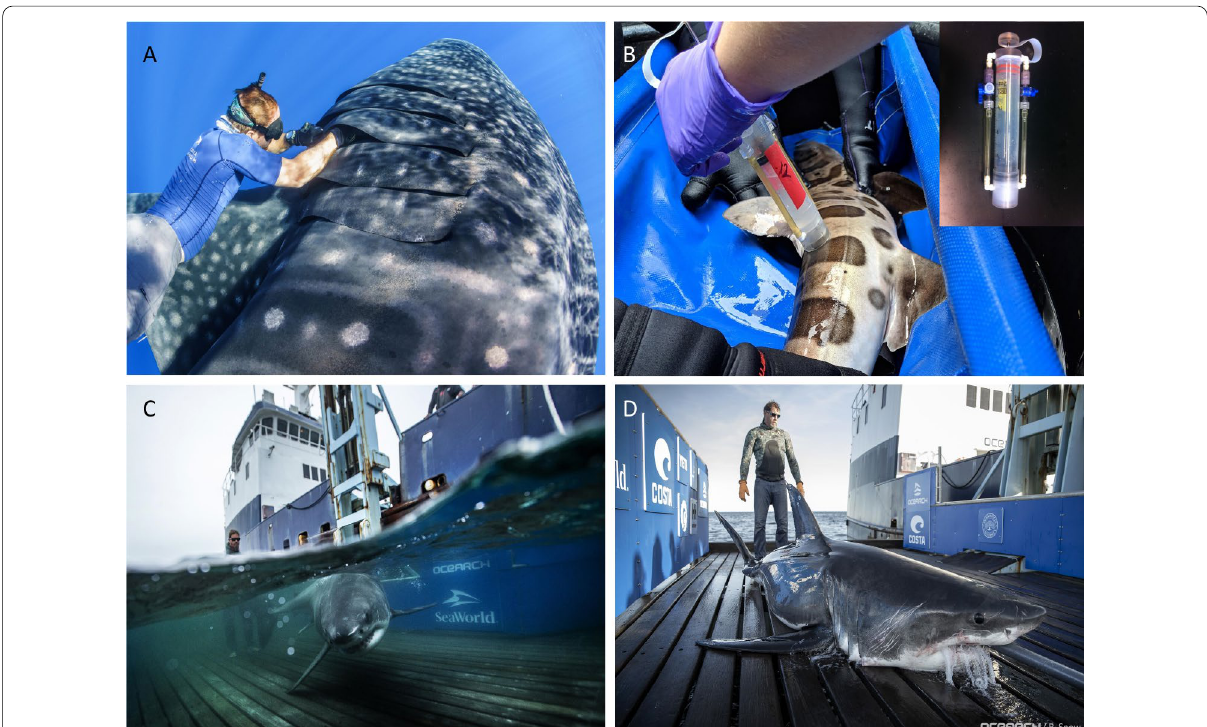
Fig. 1 Sampling elasmobranch microbiomes poses physical and technical challenges. Sampling techniques vary among species, locations, and research groups. Microbiome samples have been collected by freediving and swabbing free‑swimming animals ( A ) or immobilizing individuals out of water and collecting microbial biomass by swabbing or using custom equipment, such as modified suction devices ( B with inset). Sampling large pelagic individuals may involve modified vessels equipped with platforms that raise and secure caught individuals ( C , D ), providing a unique opportunity to sample species that are hard to capture and restrain. Panel A Gill swab from a free‑swimming whale shark (Simon Pierce, Marine Megafauna Foundation). Panel B Supersucker sampling device (inset: Michael Doane, Flinders University) being used to sample a leopard shark (Elizabeth Dinsdale, Flinders University). Panel C White shark on submerged OCEARCH platform (Robert Snow, OCEARCH). Panel D White shark on raised OCEACH platform being secured prior to sampling (Robert Snow,